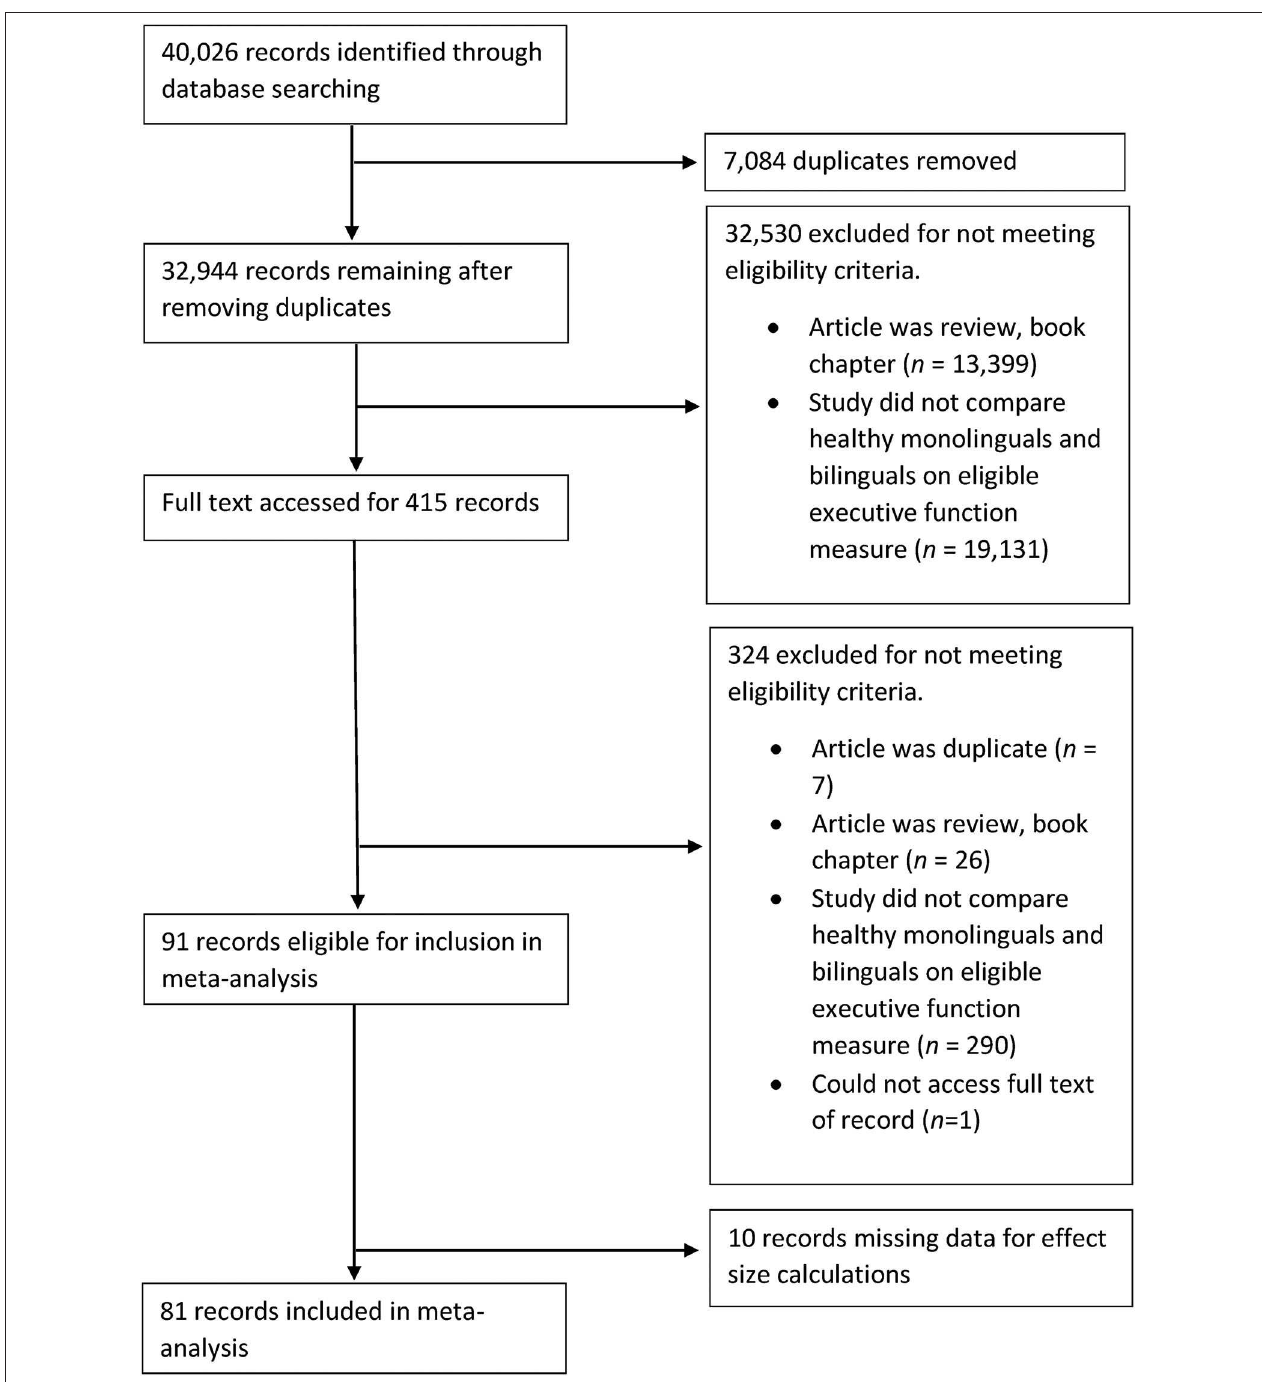
FIGURE 1 | PRISMA flowchart detailing the first search of the literature undertaken in January,